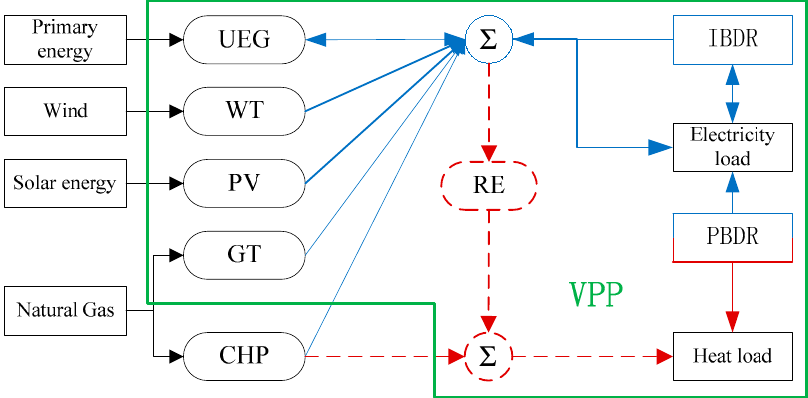
Figure 1. Basic structure of a hybrid energy system (HES).